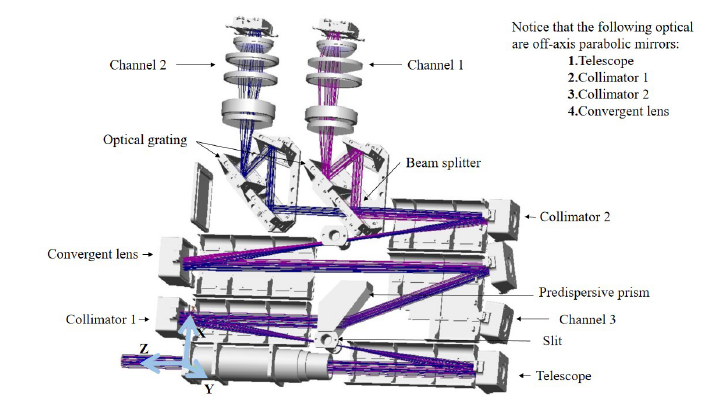
Figure 2. Internal structure diagram of the UV hyperspectral